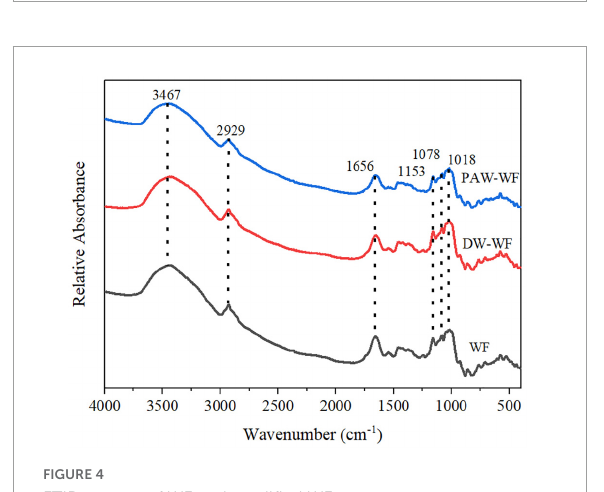
FIGURE4 FTIR spectra of WF and modified WF.